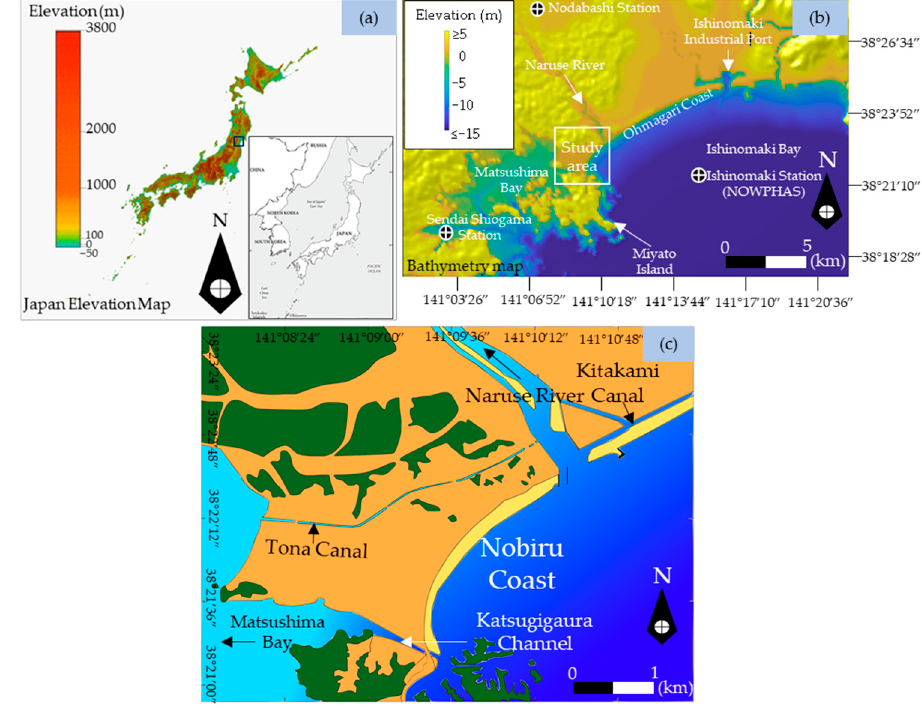
Figure 1. Map of study area. ( a ) Map of Japan. ( b ) Bathymetry of Matsushima Bay and Ishinomaki Bay. ( c ) Location of the Nobiru Coast.